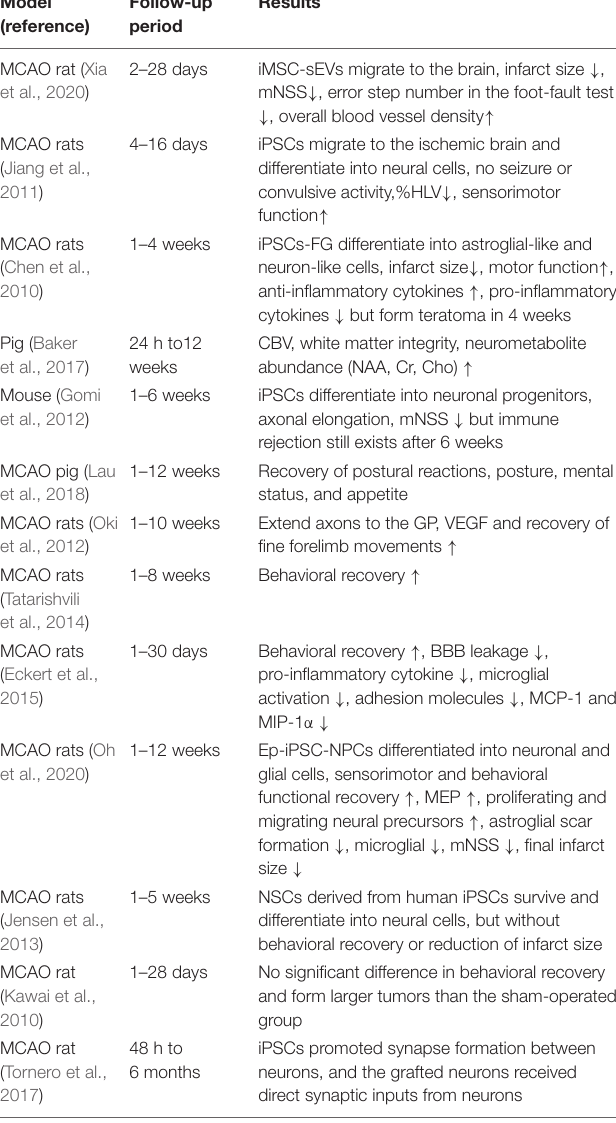
TABLE 1 | Summary of iPSC transplantation experiments in ischemic stroke